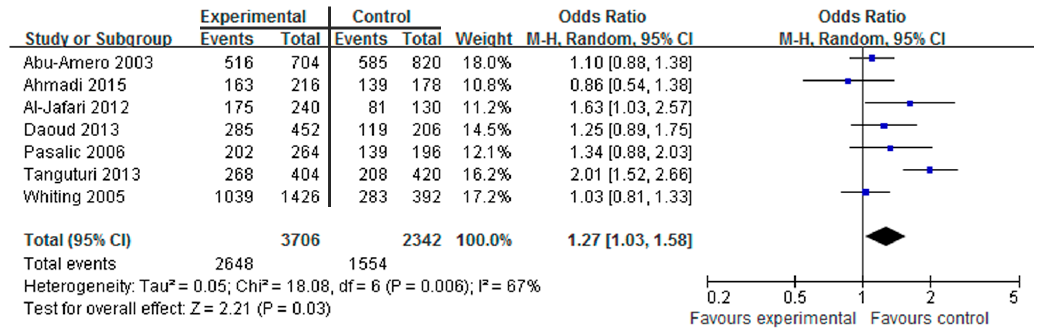
Figure 2. Forest plot of HindIII H + H + genotype associated with CAD risk.